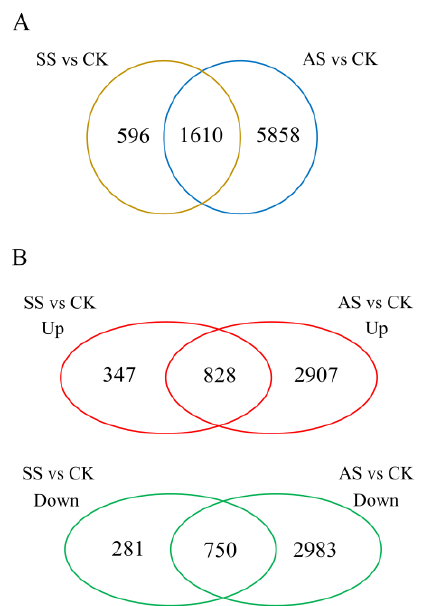
Figure 2. Differential gene expression analysis of the SS vs. CK and AS vs. CK comparisons. ( A ) Venn diagram of overlapping differentially expressed genes (DEGs) among salt-alkali stress comparisons. ( B ) Venn diagrams illustrating the overlap between the upregulated and downregulated genes in the SS vs. CK and AS vs. CK comparisons.